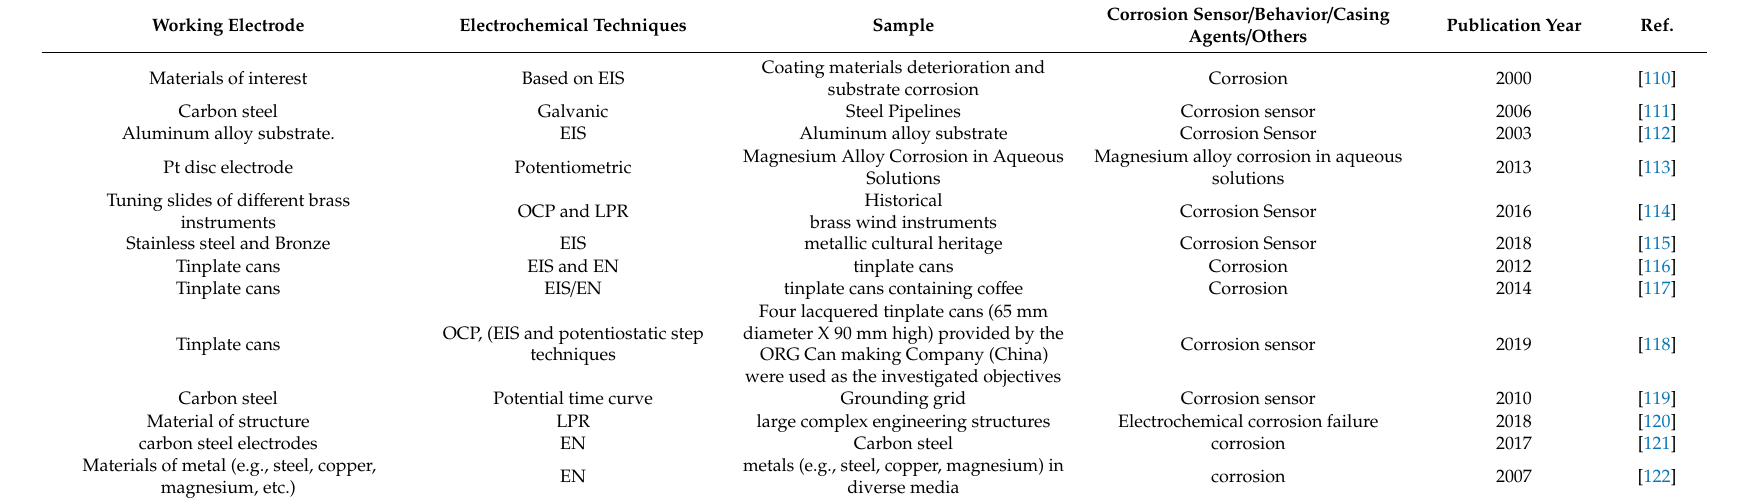
Table 7. Corrosion sensor for monitoring corrosion in another